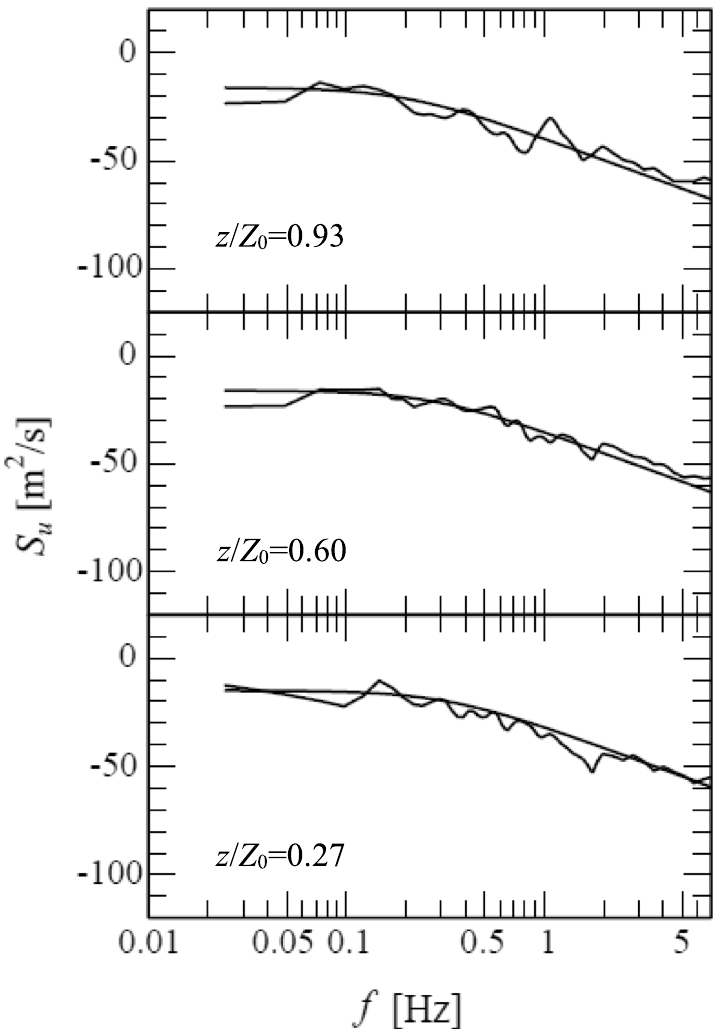
Fig. 6 Comparison of the power spectrum between the target and generated flows (Nishi et al.,